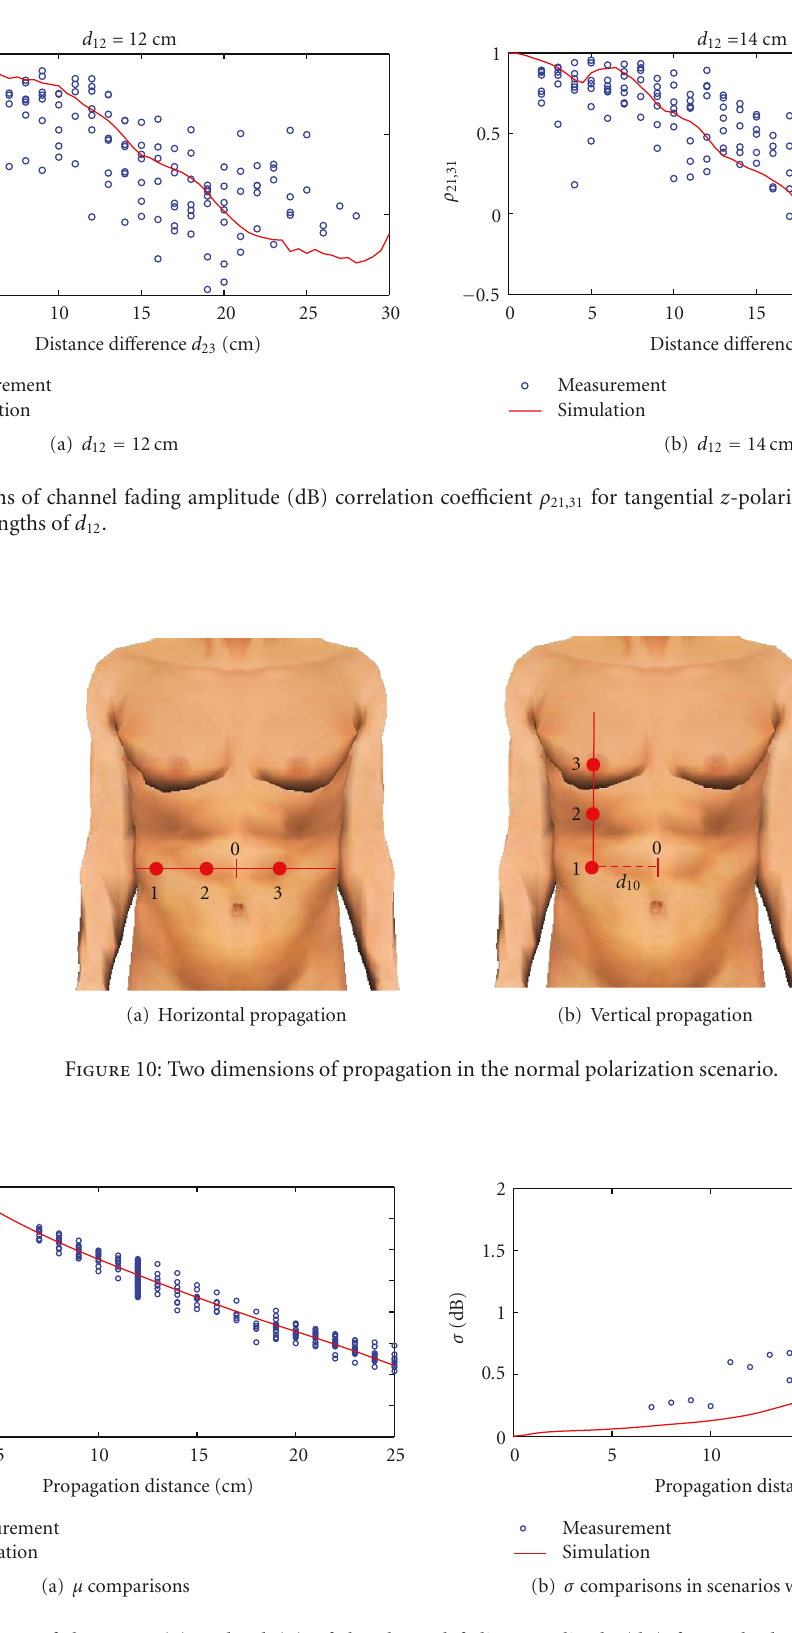
Figure 11: Comparisons of the mean ( μ ) and std ( σ ) of the channel fading amplitude (dB) for on-body channels around the trunk (horizontal direction) with normal